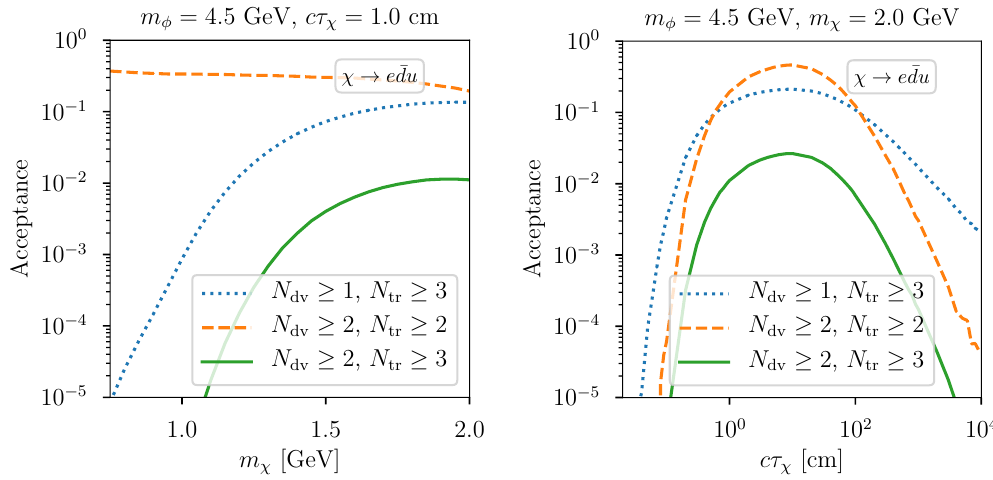
Figure 11 . Slices of the event acceptance probability for LLPs χ decaying to e + hadrons for the B → Kφ, φ → ¯ χχ production mode and m φ = 4 . 5 GeV . The left (right) panel shows the acceptance as a function of the LLP mass for cτ